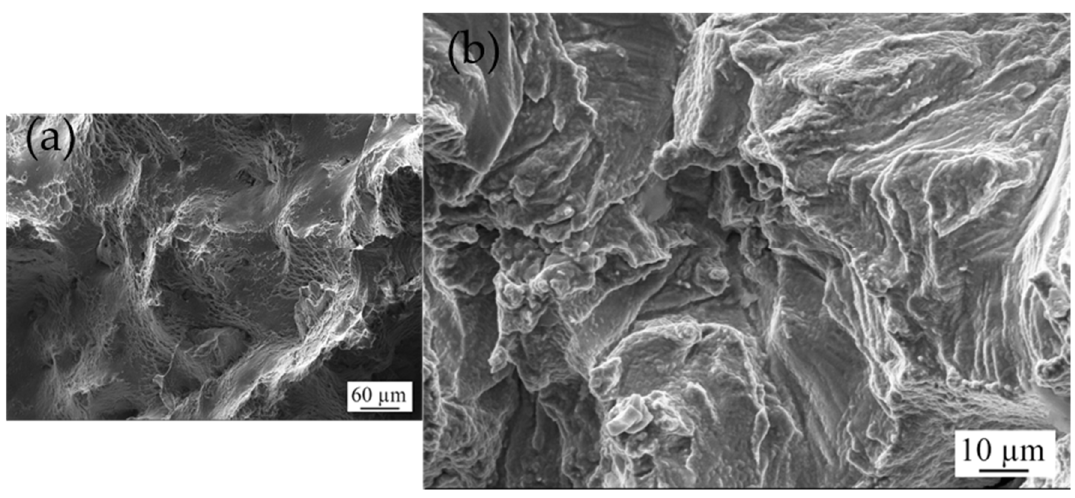
Figure 10. Fracture surface of 1190 °C heat-treatment condition tested at 1150 °C. ( a ) Typical dimples occurring in ductile fracture, ( b ) higher magnification showing traces of liquation covering fracture surface with small round features.